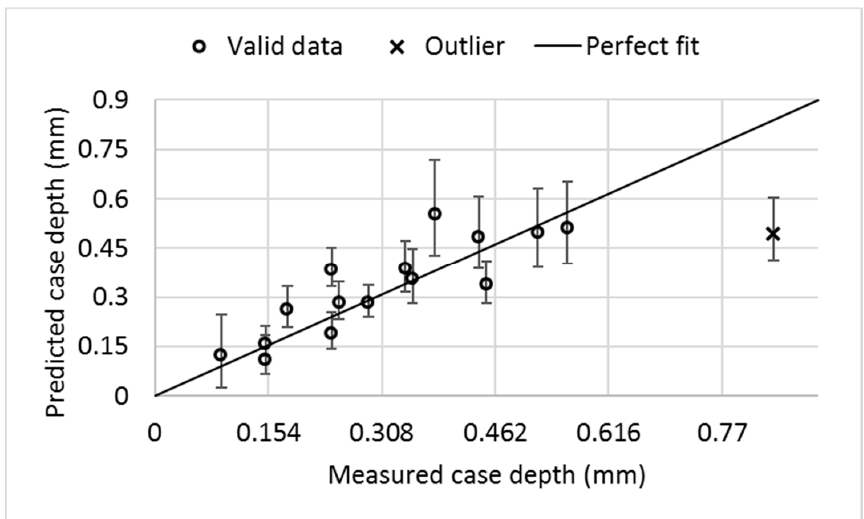
Figure 8. Predicted vs. measured case depth with the non-ground sample data set. The predictions are obtained from the model of the logarithm of case depth. obtained from the model of the logarithm of case